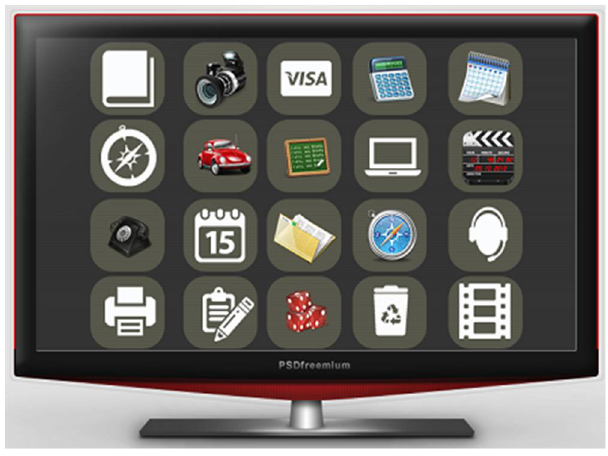
Figure 6. Screen displayed to users in Step 6 (click on the calendar icon).